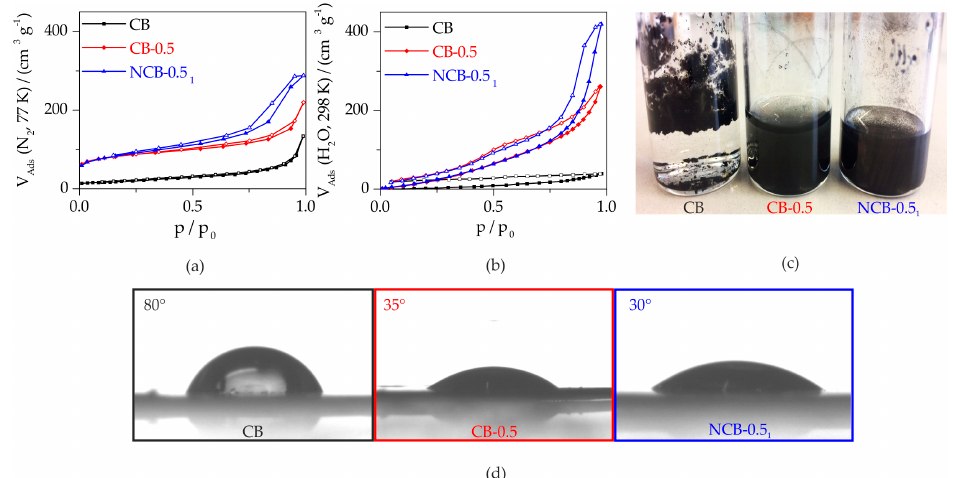
Figure 3. ( a ) Nitrogen physisorption at 77 K; ( b ) water adsorption isotherm at 298 K; ( c ) image of the samples CB, CB-0.5, and NCB-0.5 1 dispersed in pure water; and ( d ) contact angle measurement of the different CB samples.